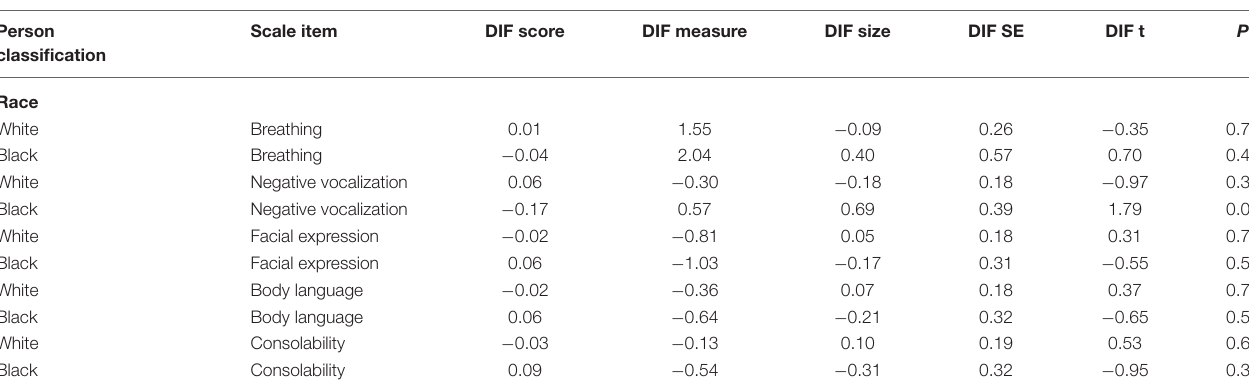
TABLE 3 | DIF analysis for evidence of pain across racial groups. Person